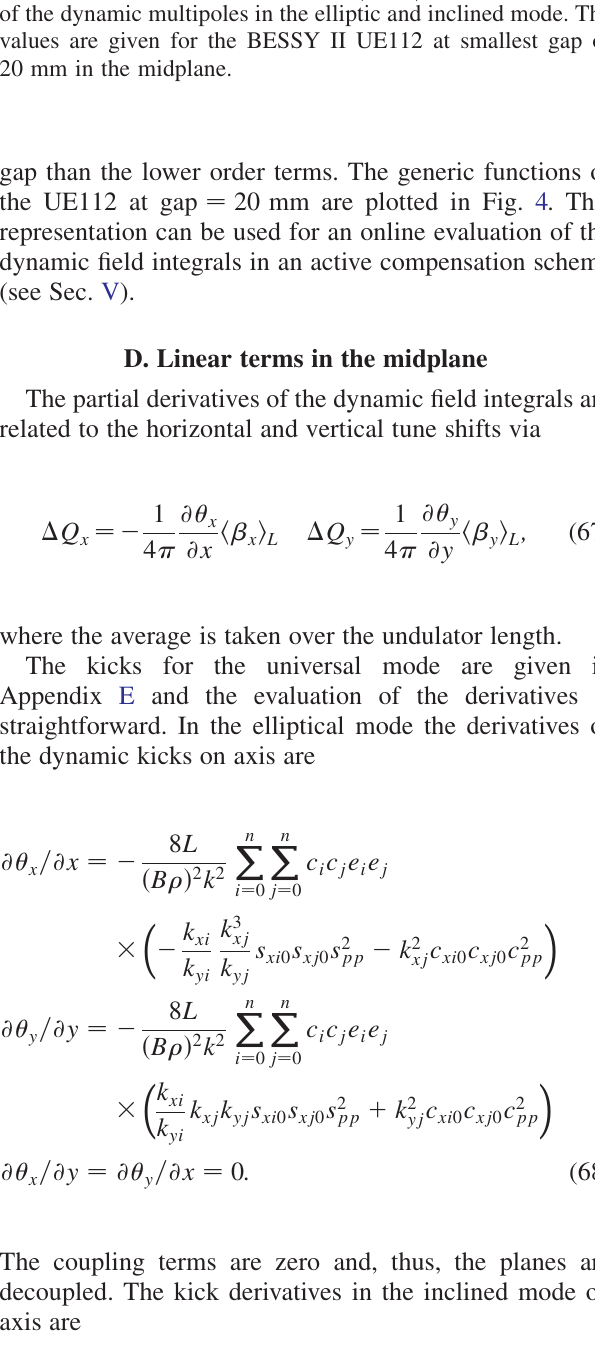
, f , g for the description (cid:5) (cid:5)= 2 (cid:5)= 2